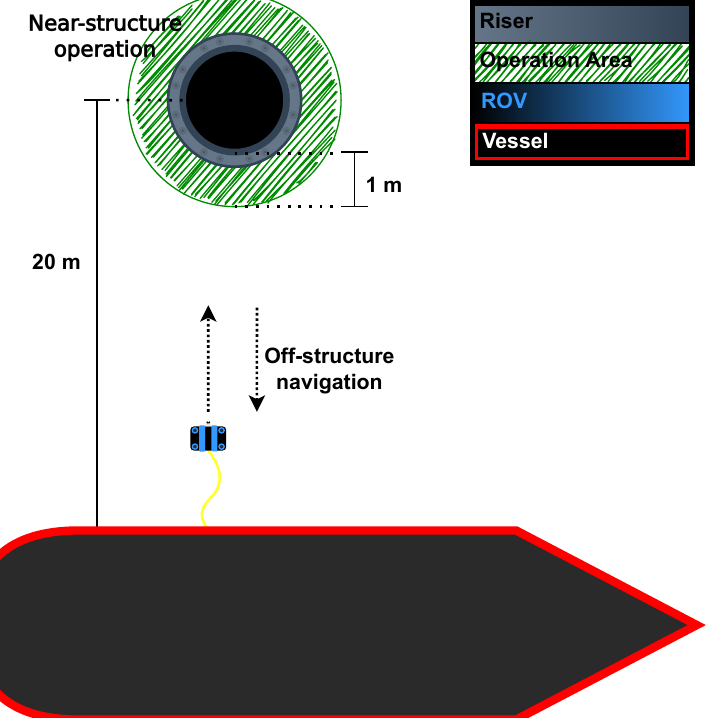
Figure 2. Cleaning mission example. The shaded green area is the operation area where a near- structure operation is